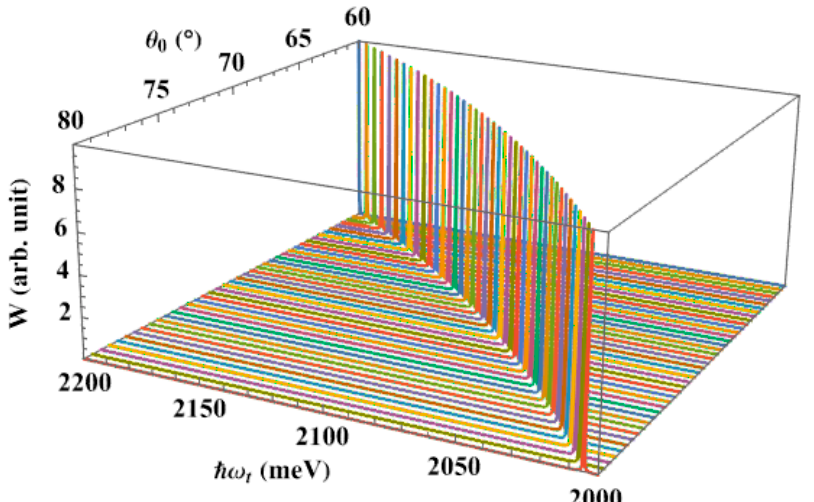
50 R = 60 q = , in both the scenario where the pump laser is